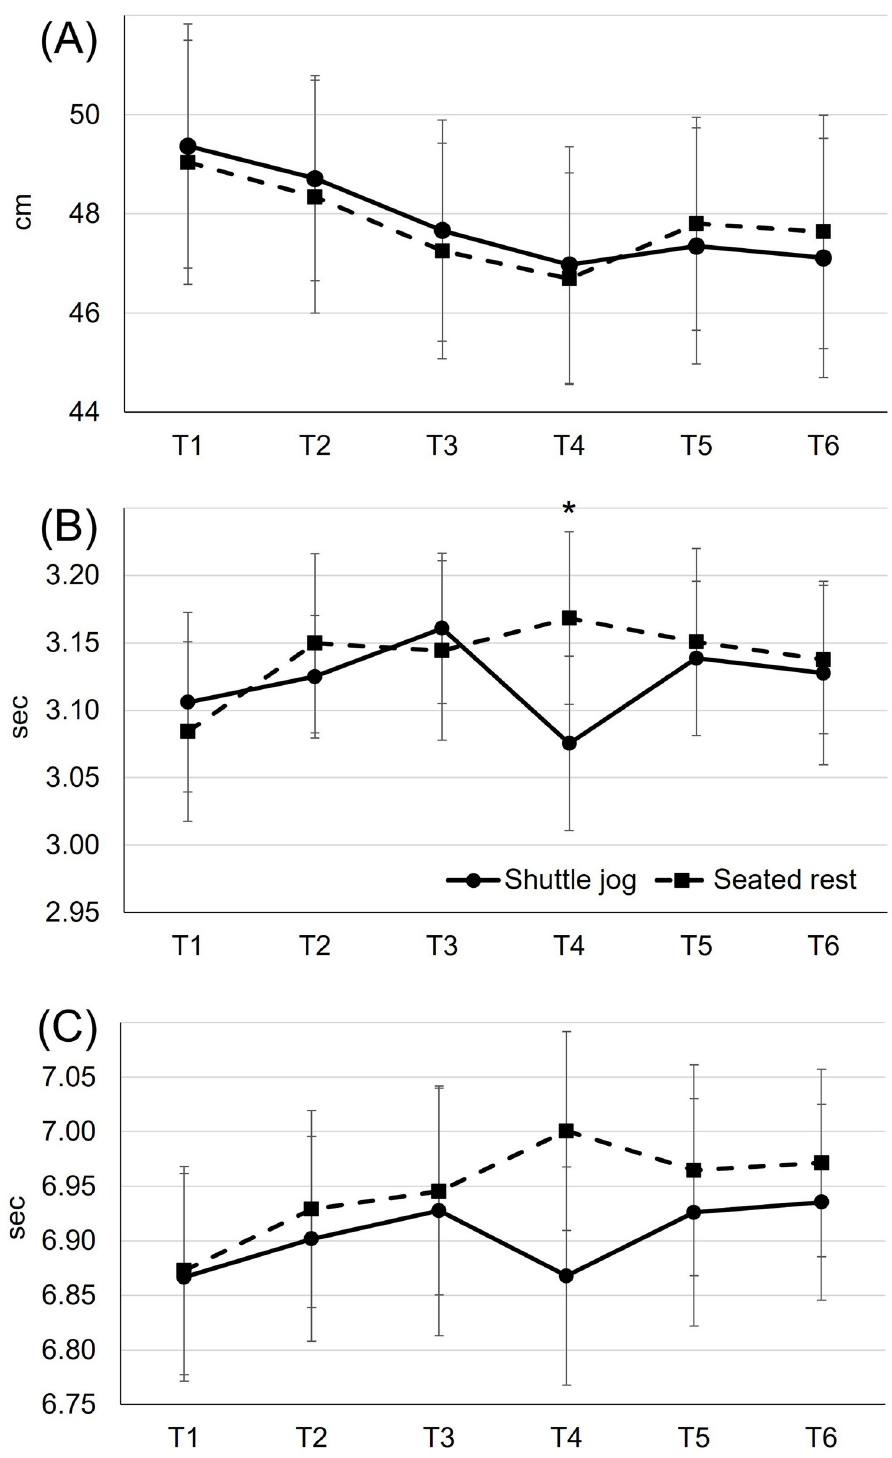
Fig 4. Changes in maximal vertical jump height (A), 20-m sprint time (B), and Arrowhead agility test time (C) over time. Values are means and the upper and lower bounds of 95% confidence intervals. � A difference between conditions during T4 ( p = 0.002, 3.08 vs. 3.17 sec, 3%, ES = 0.68).